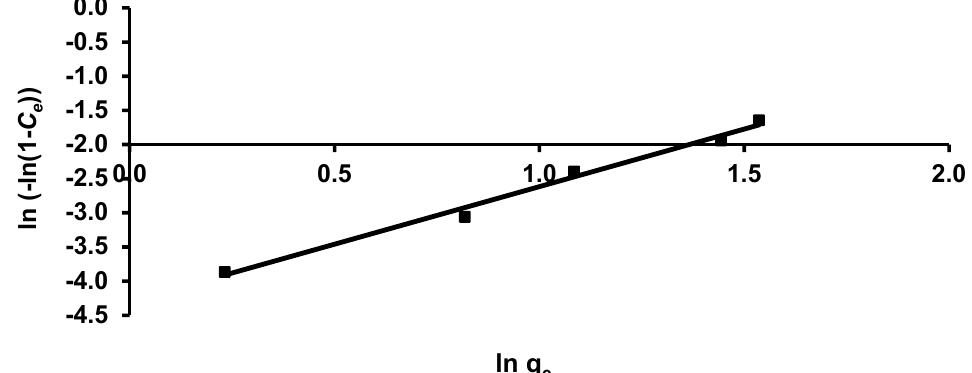
Figure 13. Halsey isotherm of the removal of IV2R.